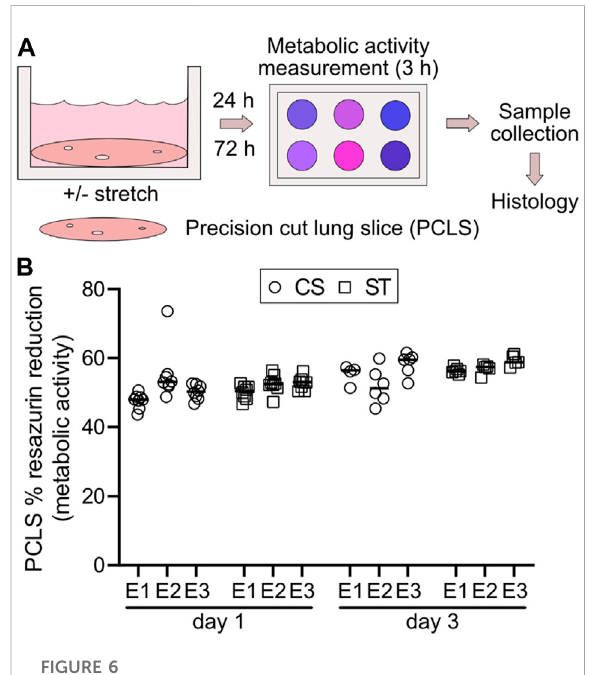
FIGURE 6 ExperimentaloverviewofPCLScultureandmetabolicactivity measurement with or without cyclic stretch. Rat PCLS were mounted in the stretching device and exposed to a physiomimetic mechanical stimulus for evaluation of PCLS viability in terms of metabolic activity and qualitative histological analysis after 24 h (1 day) and 72 h (3 days), in comparison to the static control counterpart (A) .Cellmetabolismwasassessedafter1and3 daysof culture by a resazurin-based assay (B) . Data points represent individual PCLS samples within each experiment (E1-3), horizontal lines show group median for each experiment. CS: cyclic stretch (circles), ST: static culture (squares). n = 3 experiments with 8 and 4-6 technical replicates for both conditions at day 1 and day 3,